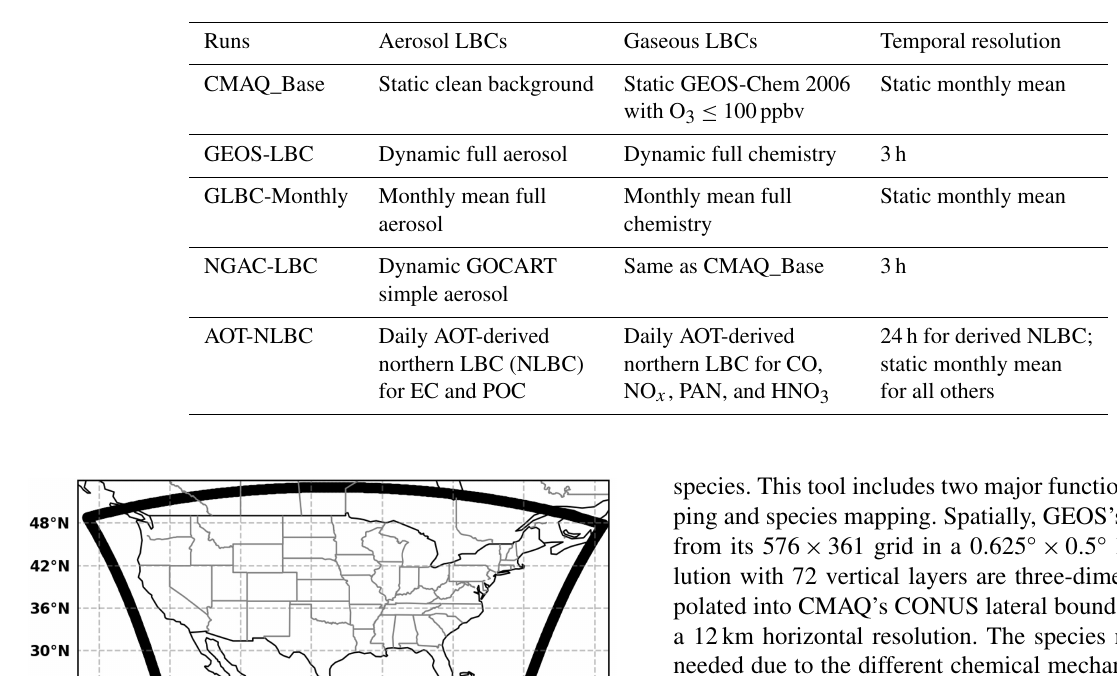
Table 1. The runs with different lateral boundary conditions (LBCs) conducted in this study. EC: elemental carbon; POC: primary organic carbon.